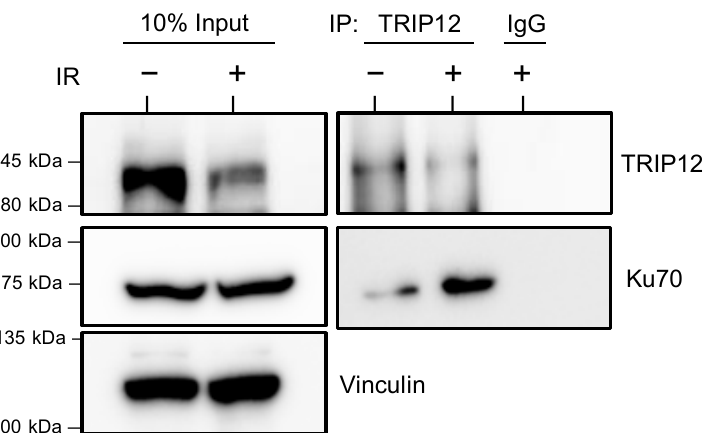
Figure 6. Ku70 interaction with TRIP12 is enhanced in response to DNA damage. HeLa cells were left untreated ( − ) or subjected to 40 Gy of IR (+) and whole cell extracts were prepared after 1 h incubation. Immunoprecipitation was performed ( n = 3) with a TRIP12 antibody (or control IgG) and immunoprecipitates were analyzed with antibodies Ku70 and TRIP12. Equal loading of inputs was assessed with a vinculin antibody.